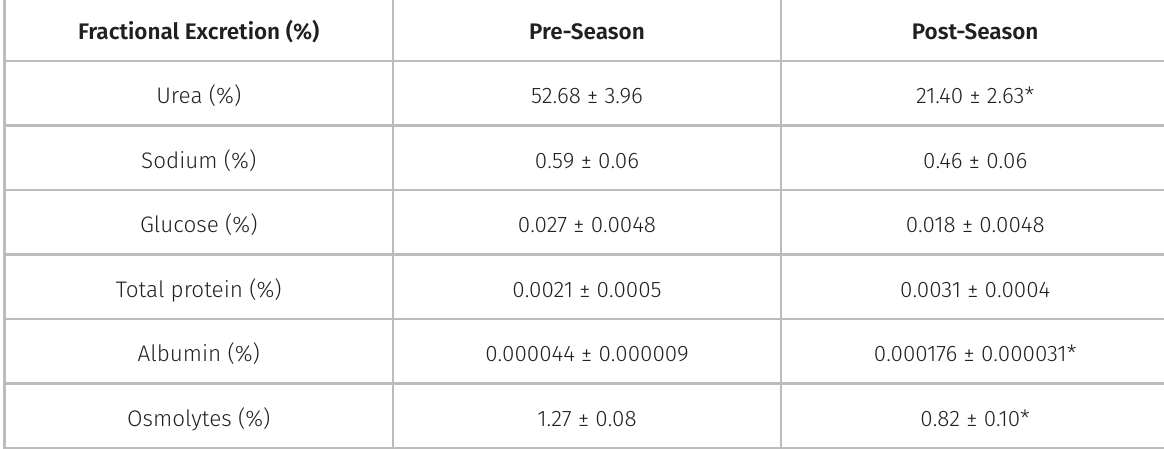
Table IV. Fractional excretion of urinary solutes (Mean ±